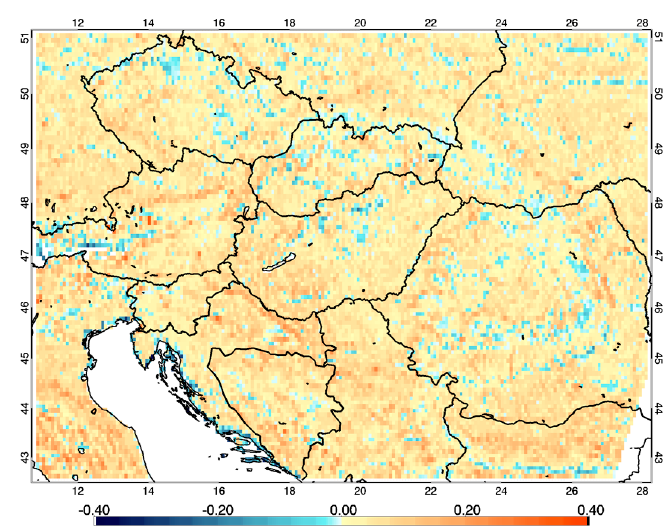
Figure 2. Bias map of the original NDVI3g O relative to NDVI MODIS during the overlapping 14 years, calculated for the time period between the second half of April and the first part of September. Positive bias means higher NDVI3g O .